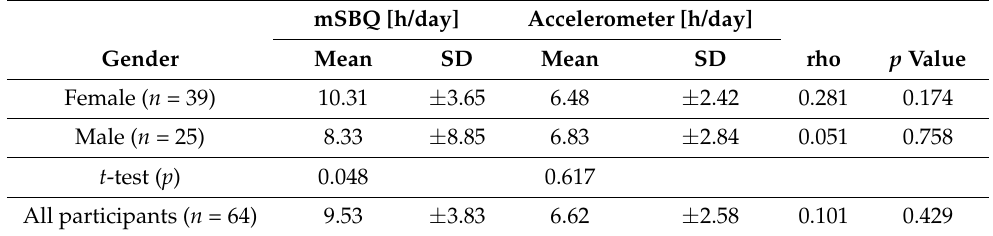
Table 4. Daily average sedentary time assessed by mSBQ and